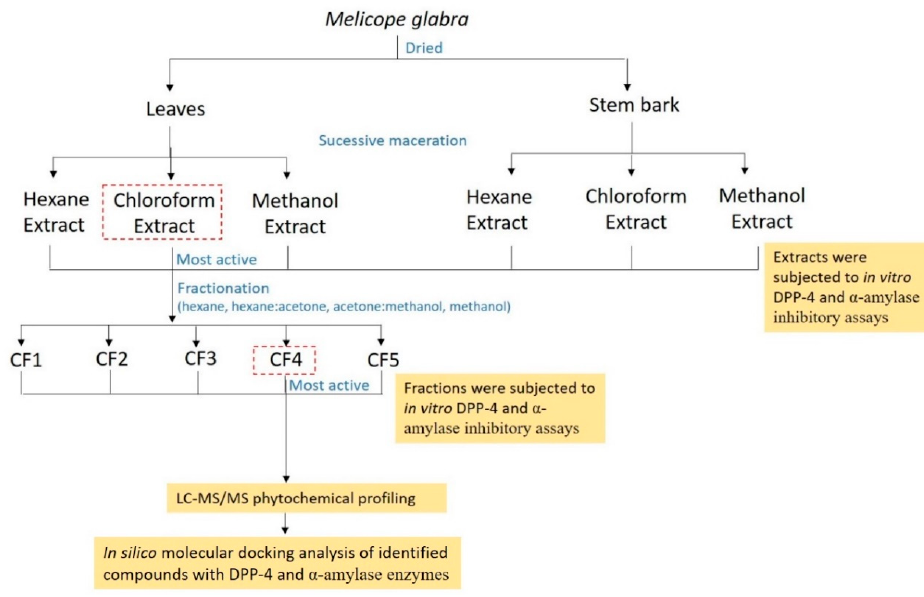
Figure 4. Schematic diagram of the overall flow of the experiment conducted on M. glabra .